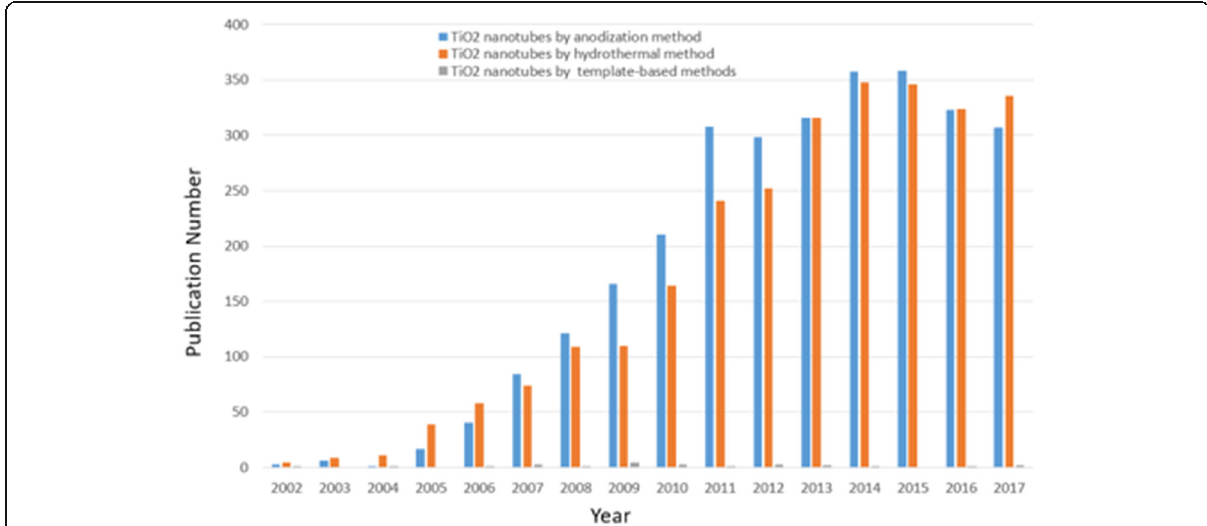
Fig. 1 Research trend. The number of papers broken down per year related to TiO 2 nanotubes differentiated by different synthesis methods from 2002 to 2017. (Data were collected from Science Citation Index Expanded using titania nanotubes, and anodization or hydrothermal methods or template-based methods as